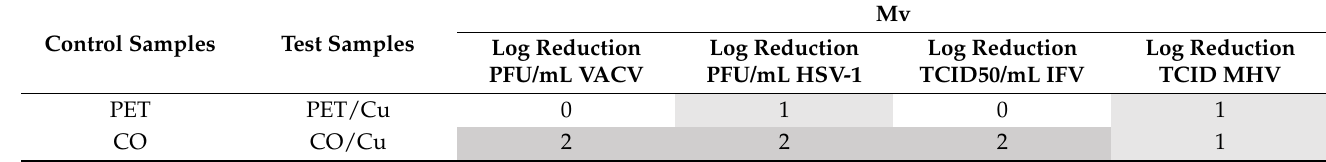
Table 4. The antiviral activity values Mv (log reduction (Vc/Vt) of modified fabrics against VACV, HSV-1, IFV and MHV.